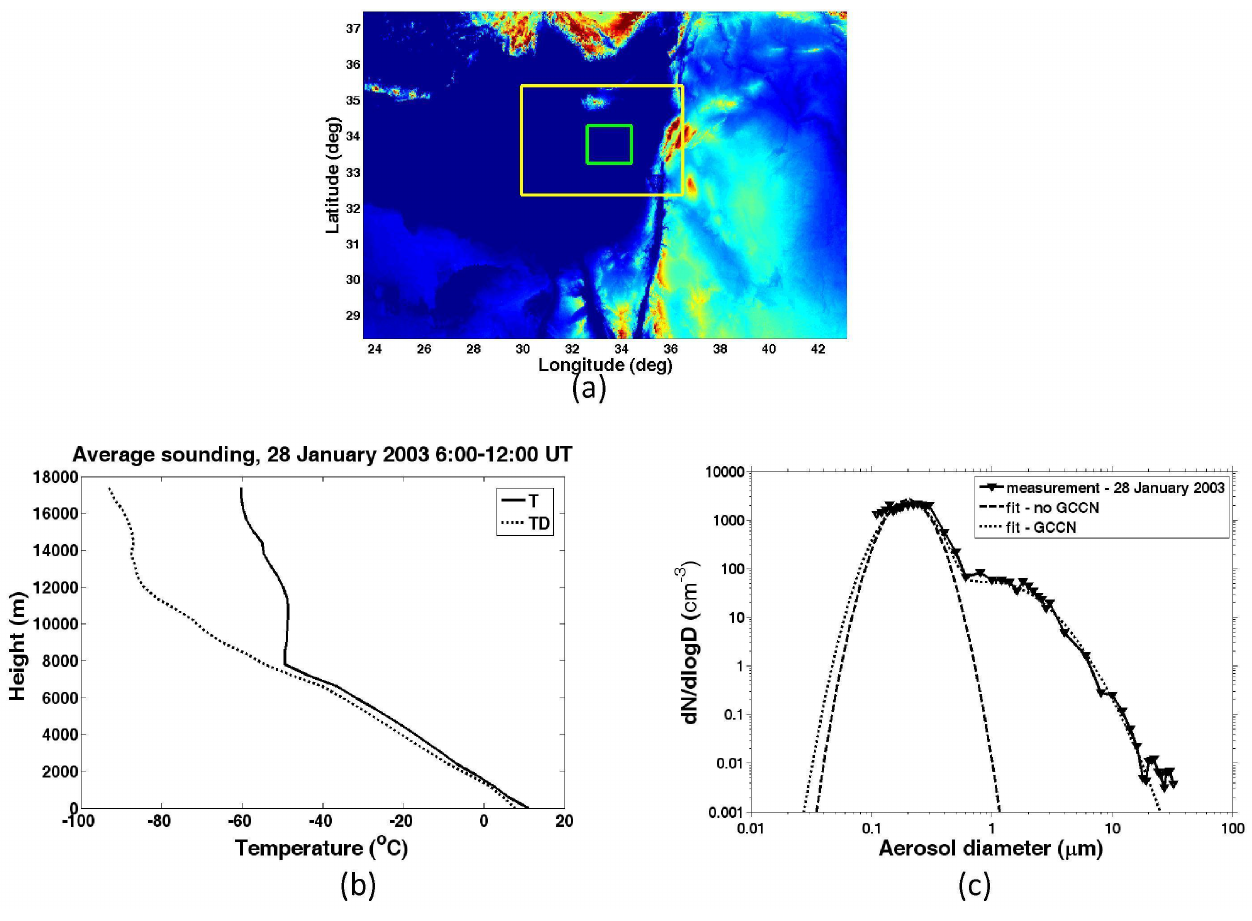
Fig. 2. Initial conditions used for the bin microphysics simulation runs. (a) Location of the three nested domains – the bin microphysics scheme was used to simulate the cloud processes at the inner domain marked in green; (b) average thermodynamic sounding showing inversion layer at around 8000m a.s.l. and − 5 ◦ C, at lower altitude the high relative humidity is clearly identified; (c) aerosol size distribution measured by the King Air airplane on the same day and at the same area – the data were taken from Levin et al.